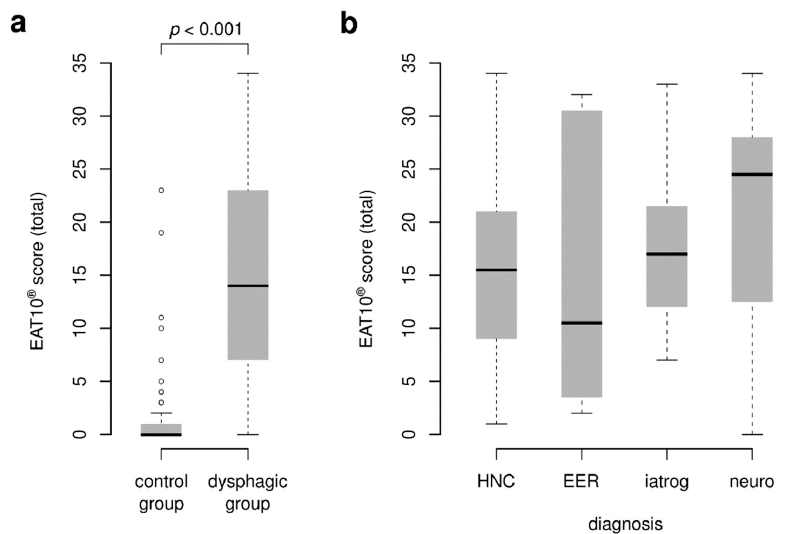
Figure 1. Clinical validity of EAT10 ® . Boxplots visualize the distribution of the total score values for ( a ) control and dysphagic groups of respondents and ( b ) dysphagic group of respondents based on the type of diagnosis. HNC = head and neck cancer; EER = extraesophageal reflux; Iatrog = iatrogenic dysphagia; Neuro = neurogenic dysphagia.